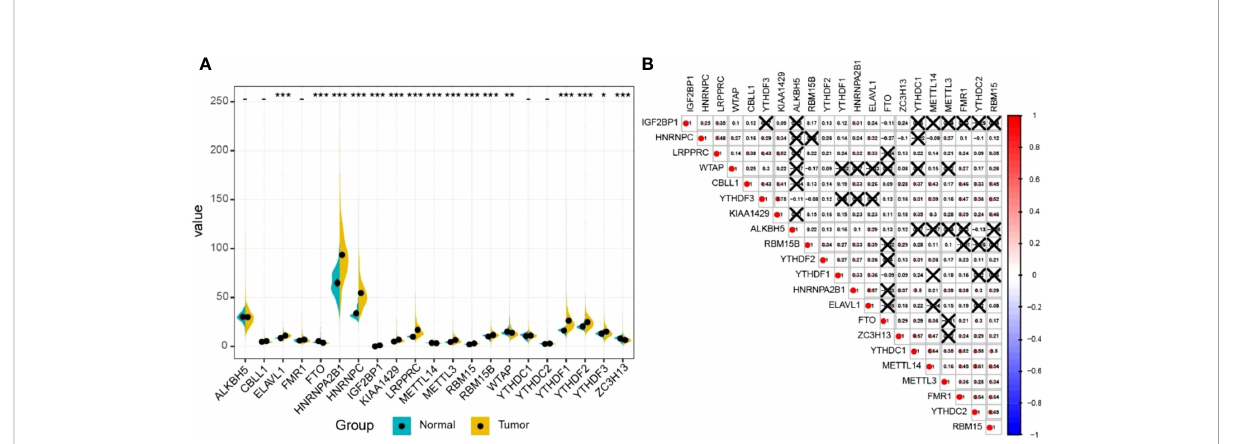
FIGURE 2 The expression pro fi le of m 6 A RNA methylation regulatory genes in LUAD. (A) The expression of m 6 A RNA methylation regulatory genes in LUAD tissues and normal tissues. Differences between groups were tested with the Wilcoxon rank-sum test. *P < 0.05; **P < 0.01; ***P < 0.001. (B) The correlation between m 6 A RNA methylation regulatory genes. The correlation coef fi cient between genes was evaluated through the Pearson correlation test. The number represents the correlation coef fi cient, and × means no statistical signi fi cance (P >